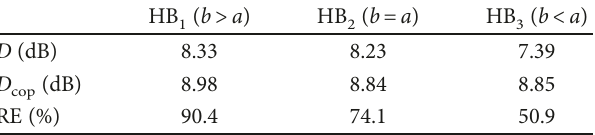
Table 4: Directivity and radiation e ffi ciency.